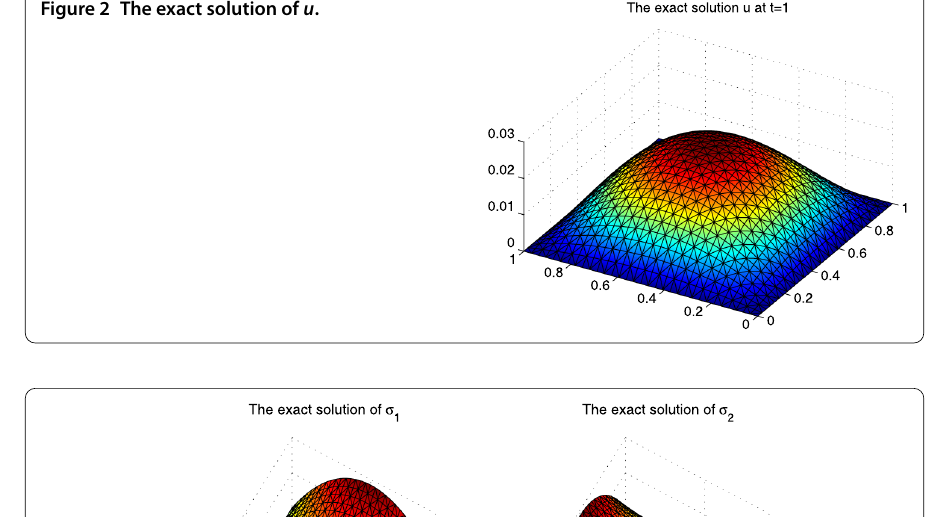
Figure 2 The exact solution of u .